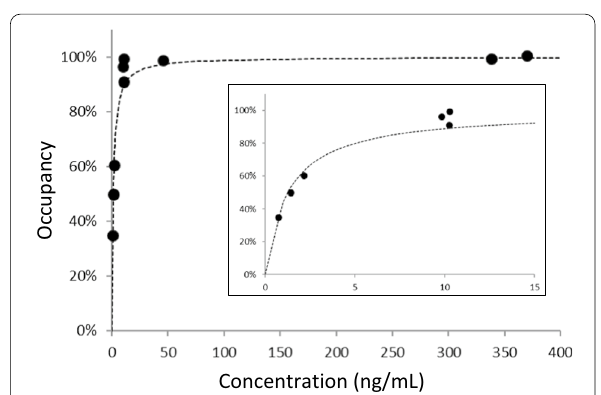
Fig. 4 Correlation of K i measured by 2TC model and Patlak slope